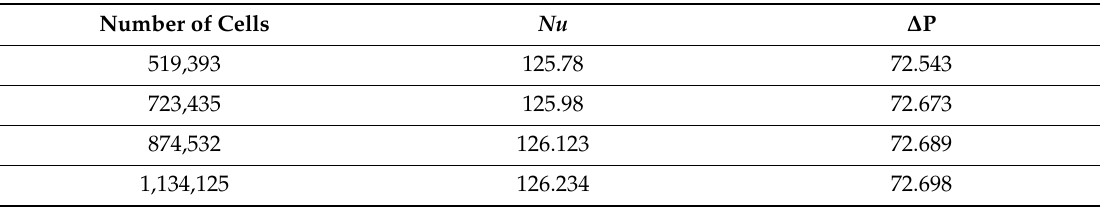
Figure 3. Mesh generation of a circular tube and twisted tape. Table 3. Values of Nu and ∆ P with four numbers of